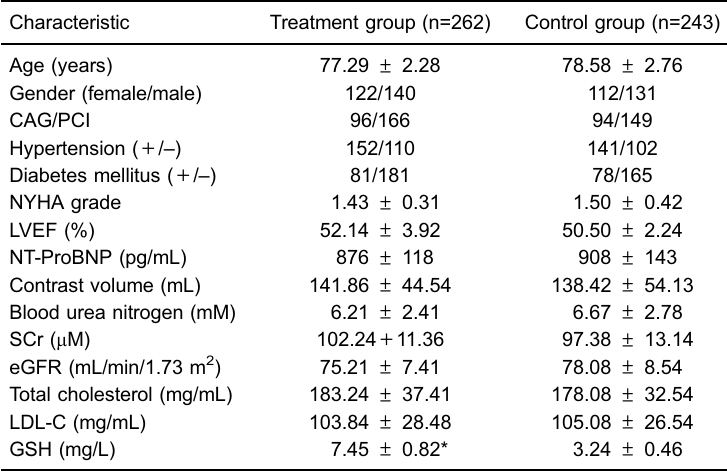
Table 1. Demographic and baseline characteristics of the two